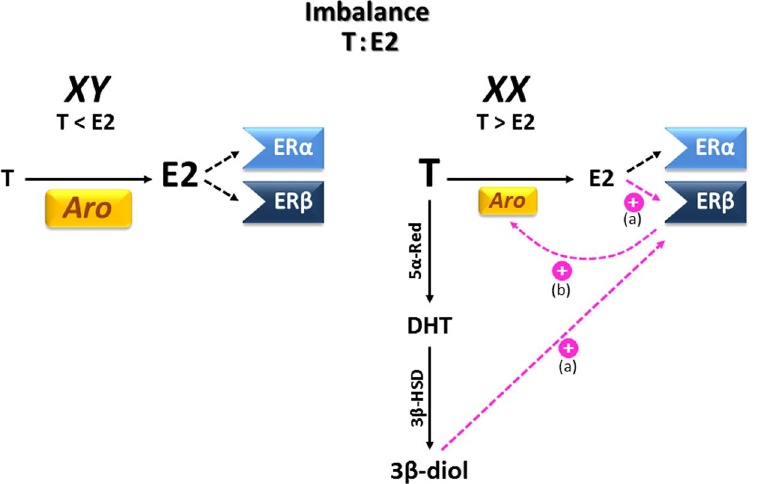
Figure 9. Summary of the effects of sex steroids in aromatase and ER β expression in XX and XY amygdala neurons. Differential expression of aromatase produces an imbalance in the E2:T ratio favouring E2 action in XY and T action in XX. In XY amygdala high levels of aromatase may favour E2 action (E2 > T) through ER α / β . On the other hand, in XX amygdala low levels of aromatase may promote T signalling (T > E2) which is then converted by 5 α -reductase to DHT. DHT is further metabolized to 3 β -diol that preferentially binds more to ER β than to ER α . E2 or DHT exposure increased ER β expression only in XX amygdala cultures ( a ). Thus, the predominance of ER β activation in XX, over ER α in XY, increases aromatase expression only in